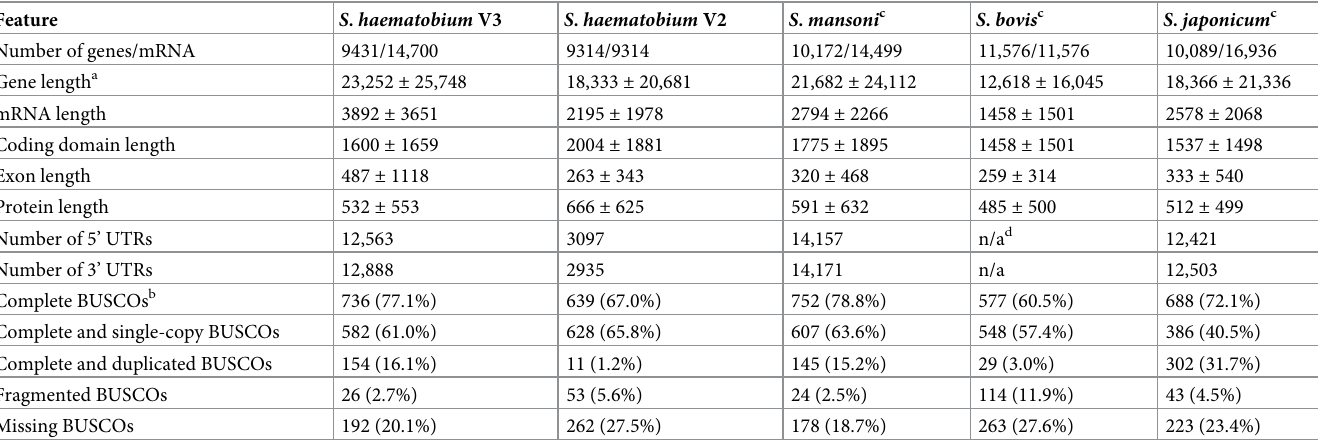
Table 2. Features of the gene and protein sets for S . haematobium V3, V2 and other key schistosome species